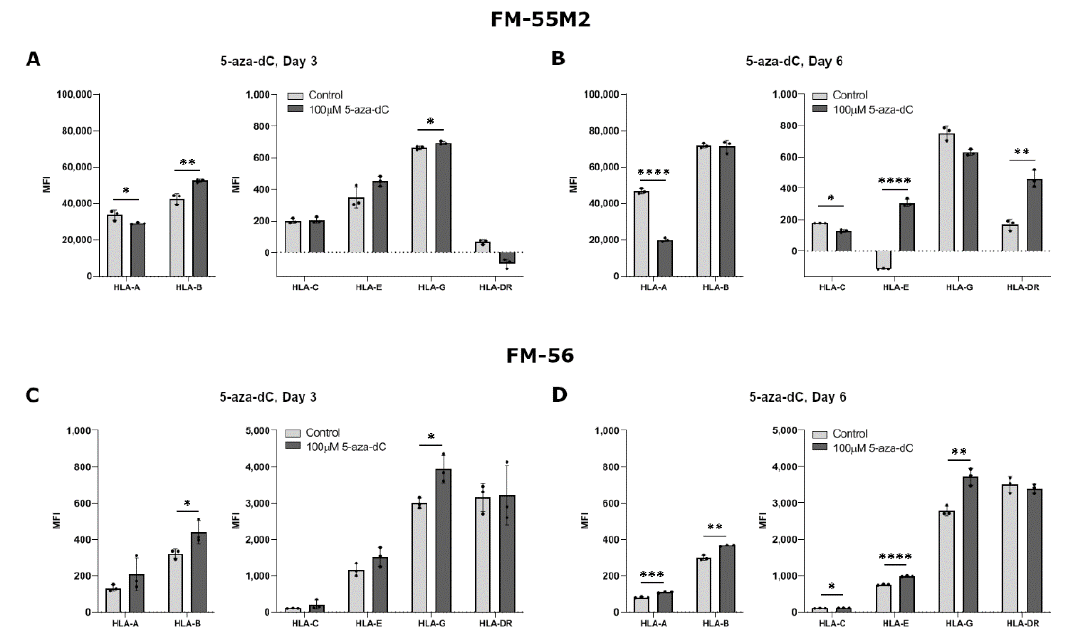
Figure 4. HLA surface expression on malignant melanoma cell lines stimulated with 5-aza-dC. Flow cytometry analysis of HLA-A, HLA-B, HLA-C, HLA-G, HLA-E, and HLA-DR expression. ( A , B ) FM-55M2 cells treated with 10 µ M 5-aza-dC for three ( A ) and six days ( B ). ( C , D ) FM-56 cells treated with 10 µ M 5-aza-dC for three ( C ) and six days ( D ). Shown are median fluorescence intensity (MFI) with mean ± SD, each dot represents one sample. The shown MFI level of control samples represent a combination of background and baseline expression. * p < 0.05, ** p < 0.01, *** p < 0.001, **** p < 0.0001 (Student’s unpaired t -test with Welch’s correction).